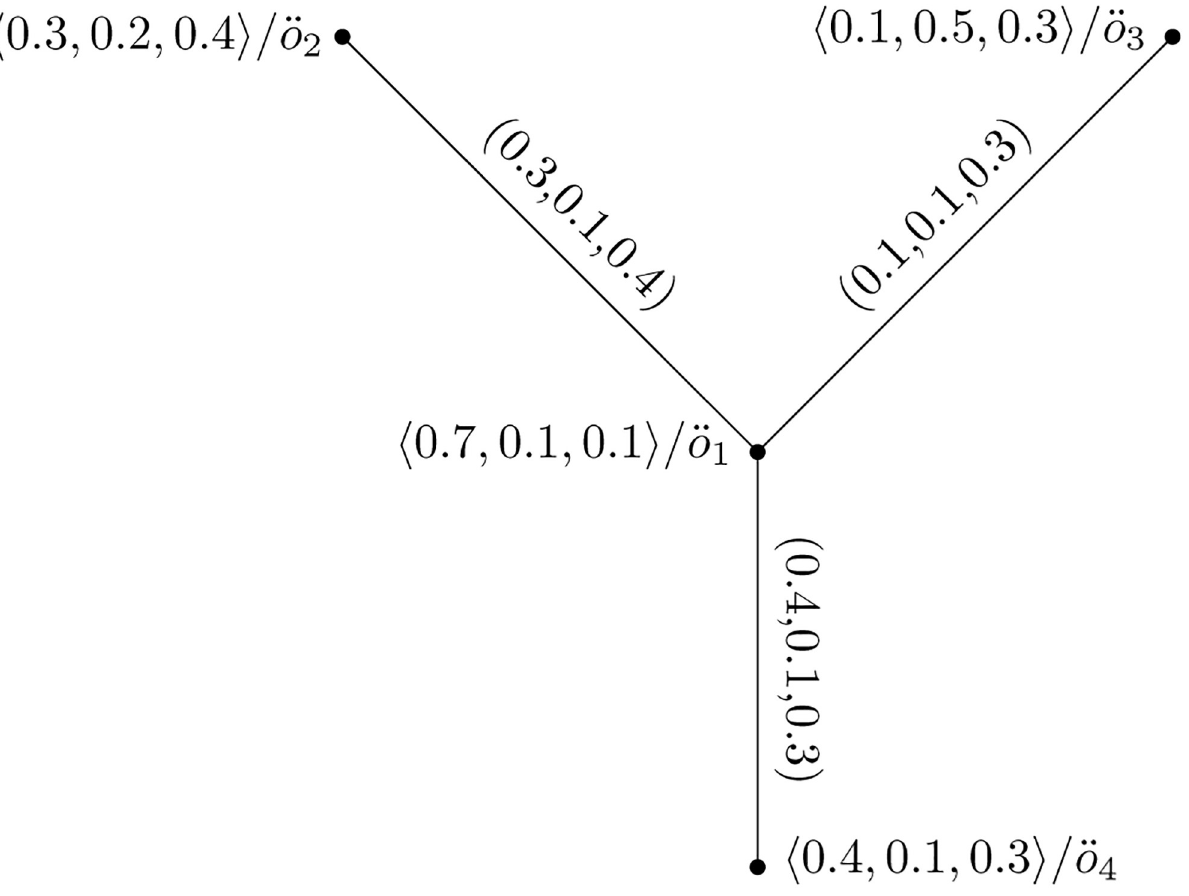
Fig 1. Picture fuzzy hypersoft graph Y